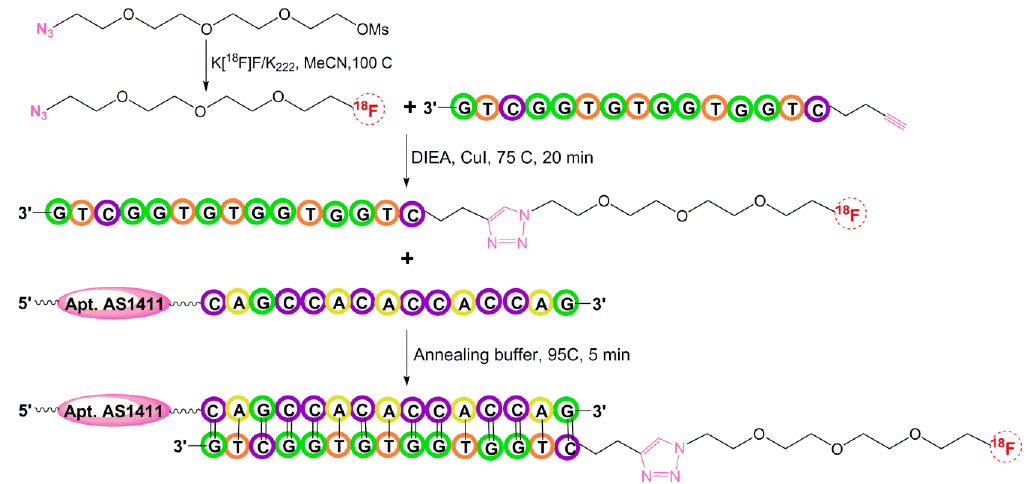
Figure 14. Schematic illustration of Hybridization ‐ based 18 F ‐ Radiolabeling.